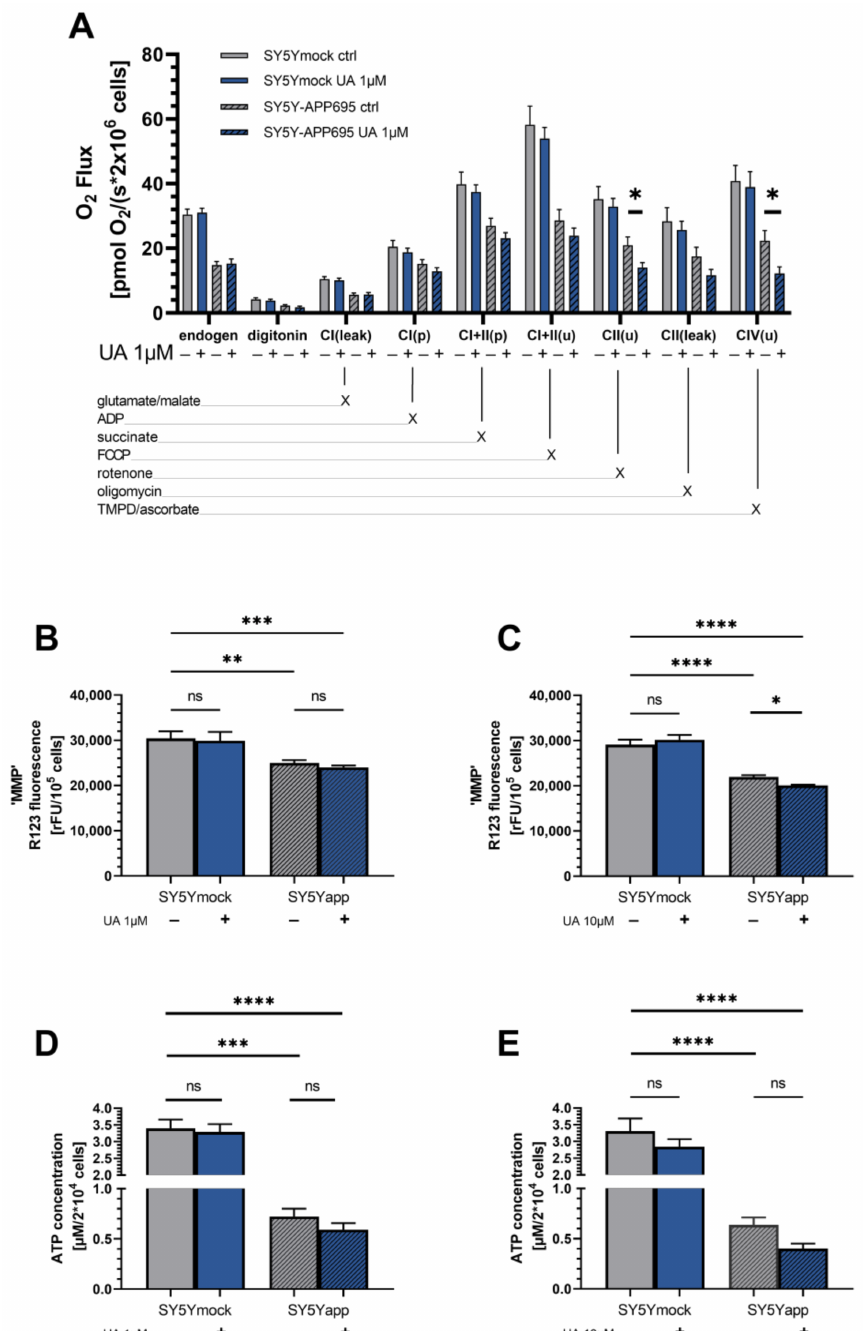
Figure 2. ( A ): Oxygen consumption of 20 6 SY5Ymock cells and SY5Y-APP695 cells treated with ctrl or 1 µ M UA. N = 9–15. Activity of OXPHOS complexes were assessed via addition of several substrates, inhibitors or uncouplers. Which substance was added in which stage of the experiment is marked with “X”. ( B , C ) Mitochondrial membrane potential measured of SY5Ymock cells and SY5Y-APP695 cells treated with 1 µ M UA ( B ) or 10 µ M UA ( C ). N = 7–11; ( D , E ) ATP levels of SY5Ymock and SY5Y-APP695 cells treated with 1 µ M UA ( D ) or 10 µ M ( E ). N = 11–13 Displayed are means ± SEM. Statistical significance was tested via two-way ANOVA followed by a false discovery rate correction according to Benjamini, Krieger, and Yekutieli. Significance is displayed as: ns p > 0.05, * p < 0.05, ** p < 0.01; *** p < 0.001, **** p < 0.0001. List of all statistical parameters and comparisons can be found in Supplementary Table